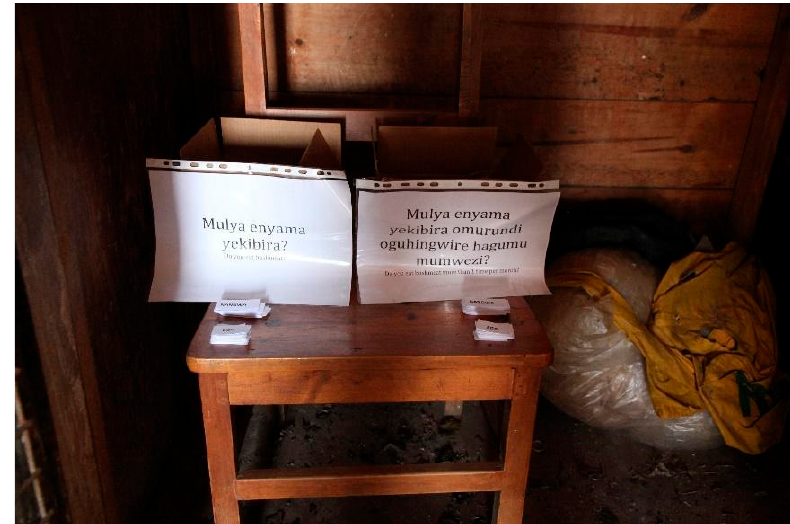
Figure A3. Ballot boxes used for group counts in one tea camp to answer the questions: “Do you eat bushmeat?”, and if yes, “Do you eat it more than once a month?” around Sebitoli area, Kibale National Park, Uganda. Animals 2023 , 13 , x